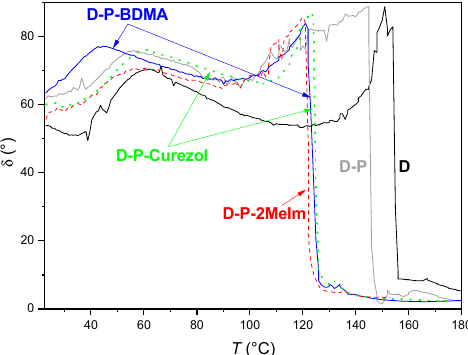
Figure 9. Phase angles of D, D-P and D-P-accelerator formulations during curing.